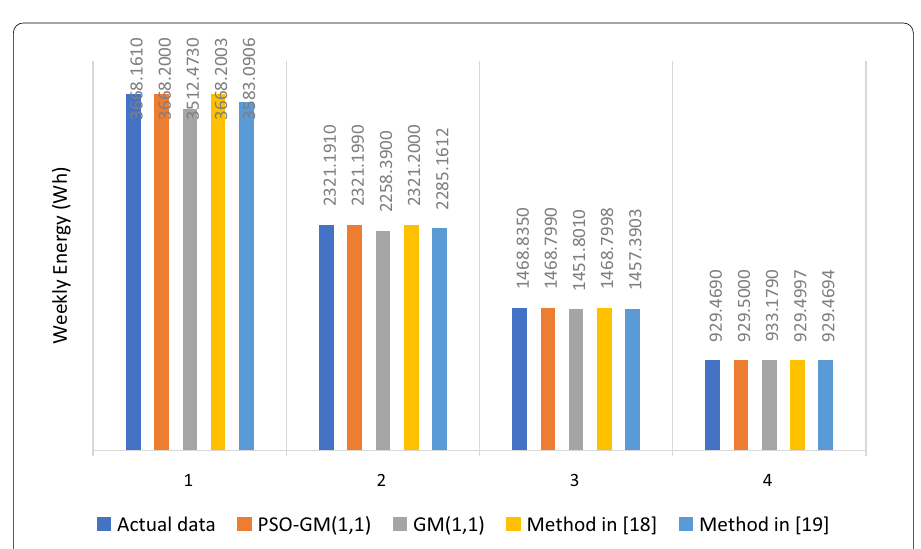
Fig. 5 Forecast results using the various models, for energy data for a desktop